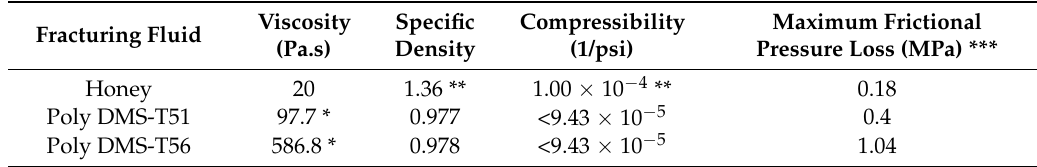
Table 2. Fracturing fluids’ physical properties.